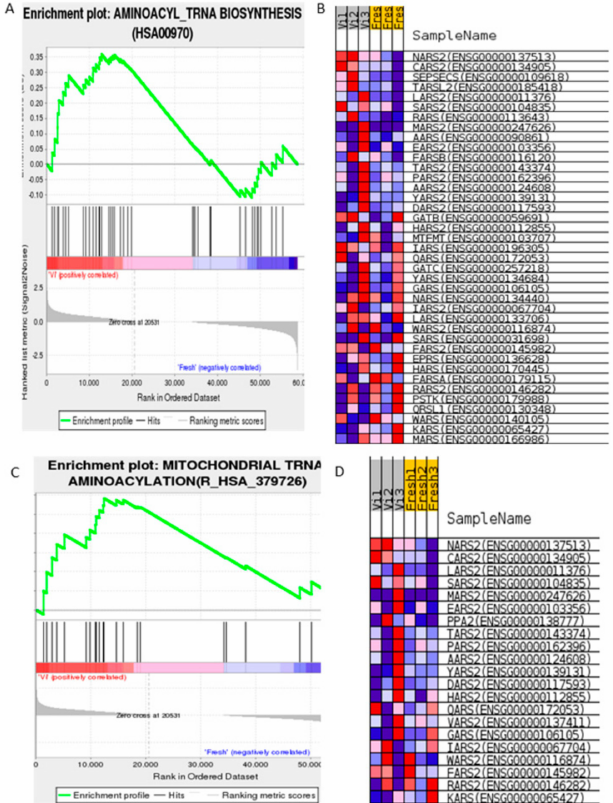
Figure 1. GSEA result for vitrified human spermatozoa: Aminoacylation process of tRNA in mi- tochondria. ( A ) Enrichment plot of aminoacylation term, GO ID: HSA00970. ( B ) Visualization of enriched genes in tRNA aminoacylation process in cryoprotectant-free vitrified spermatozoa and fresh spermatozoa groups. ( C ) Enrichment plot of mitochondrial tRNA aminoacylation term, Re- actome ID: R_HSA379726. ( D ) Visualization of enriched genes in Reactome in cryoprotectant-free vitrified spermatozoa and fresh spermatozoa groups. Running enrichment score for gene set as analysis walks down scored list shown in ( A ). Enrichment score for gene set is value at top of graph (furthest from 0.0). Gene sets with a distinctive peak at the start. Center portion of plot reveals how members of gene set are distributed in scored list. Leading edge part of gene set indicates participants that contribute most to